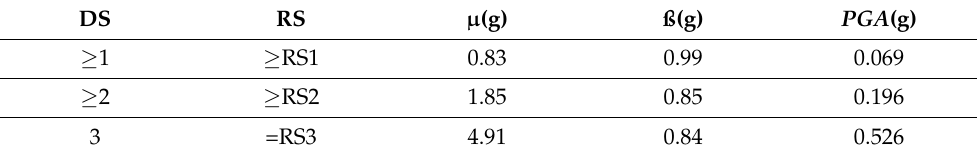
Table A4. Seismic fragility and probit coefficients for pressurised horizontal steel storage tanks. Data from Ref. [37]. (Damage State or Structural Damage (DS) are classified following the HAZUS damage classification and refer to the structural damage, whereas RS is introduced in [29] in order to define the loss of containment derived from the DS level of damage to the